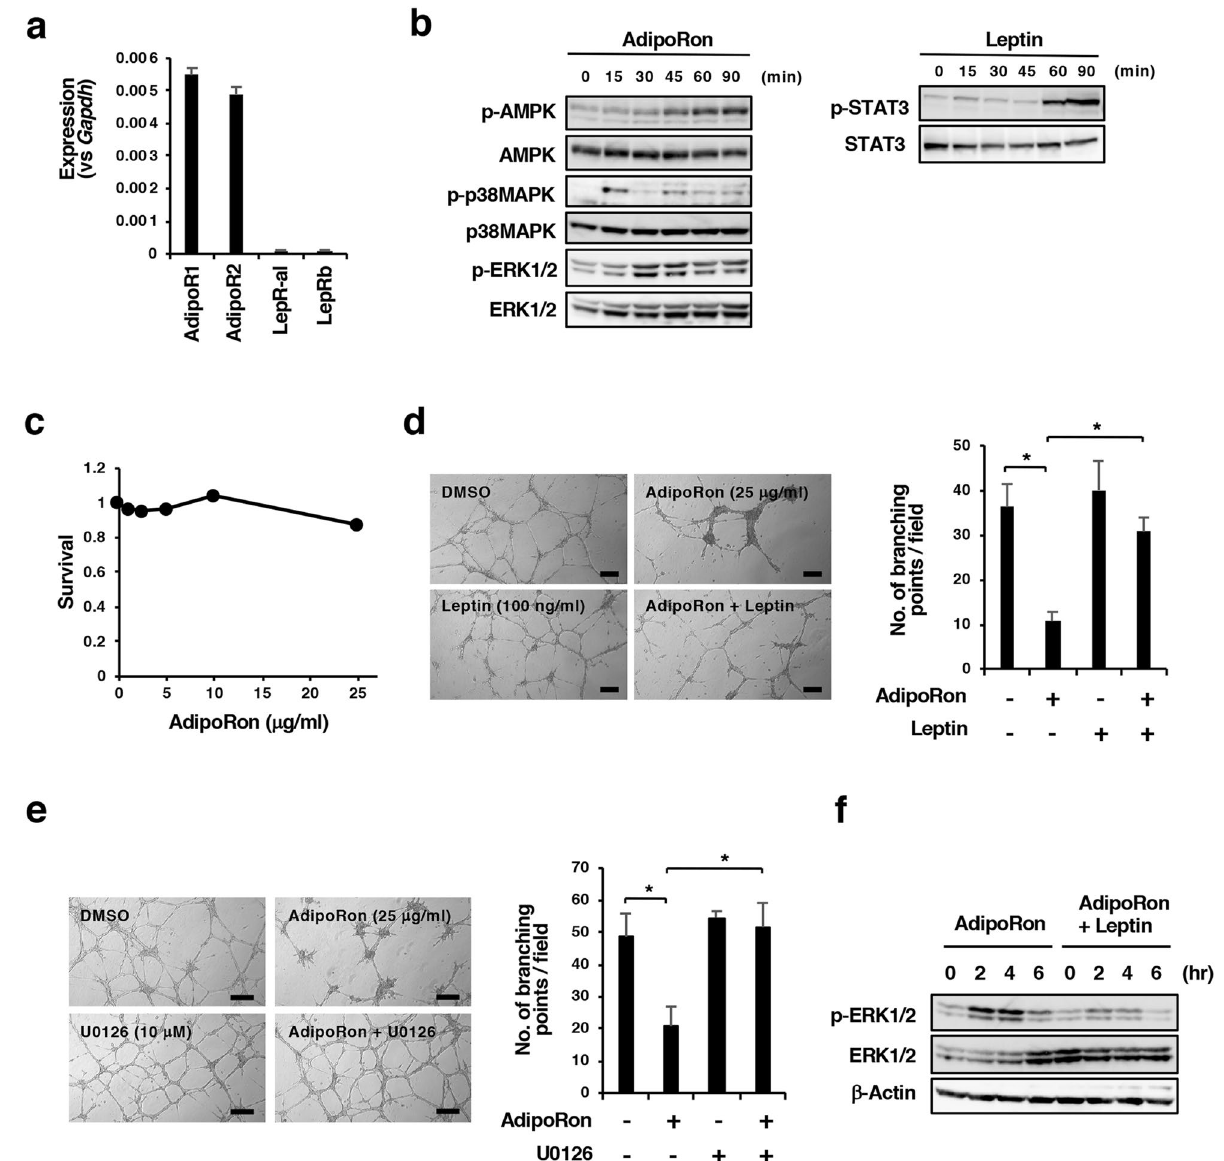
Figure 5. Effects of AdipoRon and leptin on the tube formation of MSS31 cells. ( A ) qRT-PCR analysis of the expression of AdipoRs and LepRs. ( B ) Effects of AdipoRon and leptin on the activation of AMPK, p38 MAPK and STAT3. The cells were incubated with 25 μg/ml AdipoRon or 0.5 μg/ml leptin for the indicated times. The uncropped images are shown in Supplementary Fig. S11-1. ( C ) Cell survival. The cells were incubated with various concentrations of AdipoRon for 2 days. Cell survival was measured with the MTT assay. The value for each point represents triplicate measurements. ( D ) Effects of AdipoRon and leptin on the tube formation of MSS31 cells. The cells were pretreated with leptin (100 ng/ml) for 1 h and then incubated with vehicle (DMSO) alone or 25 μg/ml AdipoRon plus 100 ng/ml leptin on Matrigel for 16 h. The number of branching points per field is also shown. Bars: 100 μm. *P < 0.01. ( E ) Effects of U0126 on AdipoRon-induced suppression of tube formation of MSS31 cells. The cells were pretreated with U0126 (10 μM) for 1 h and then incubated with vehicle (DMSO) alone or 25 μg/ml AdipoRon plus 10 μM U0126 on Matrigel for 16 h. The number of branching points per field is also shown. Bars: 100 μm. *P < 0.01. ( F ) Effects of leptin on AdipoRon-induced ERK1/2 activation in MSS31 cells. The cells were pretreated with leptin (100 ng/ml) for 1 h and then incubated with vehicle (DMSO) alone or 25 μg/ml AdipoRon plus 100 ng/ml leptin for the indicated times. The uncropped images are shown in Supplementary Fig.